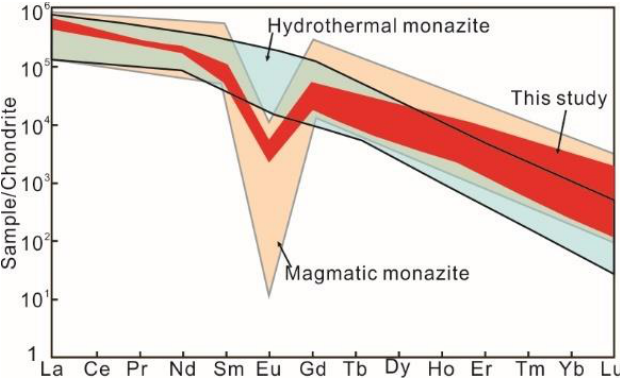
Figure 7. Normalized REE pattern of Baishi granite monazite. Chondrite data are from [43]. The red filled area represents the data of this study. The blue transparent area represents hydrothermal monazite (data from [44]). The orange transparent area represents hydrothermal monazite (data from [41]).